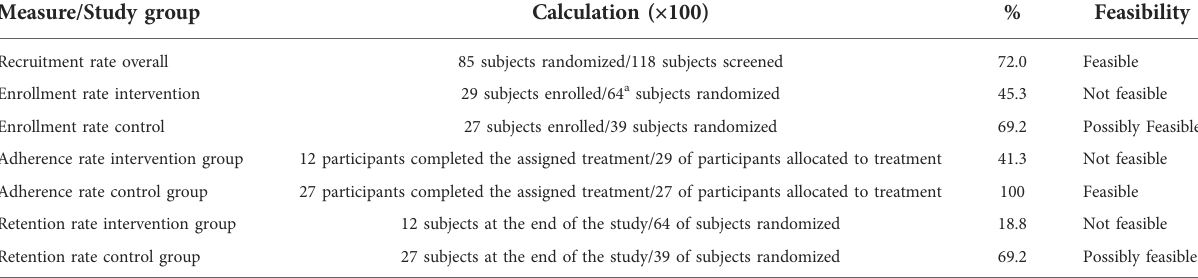
TABLE 3 Feasibility